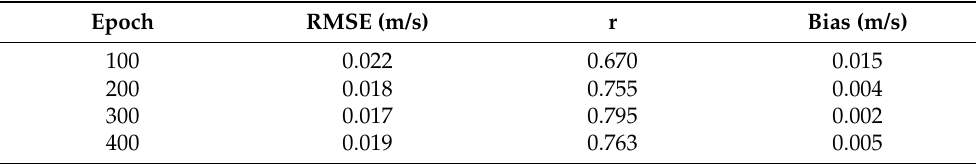
Table 4. Statistics of the estimation results under different